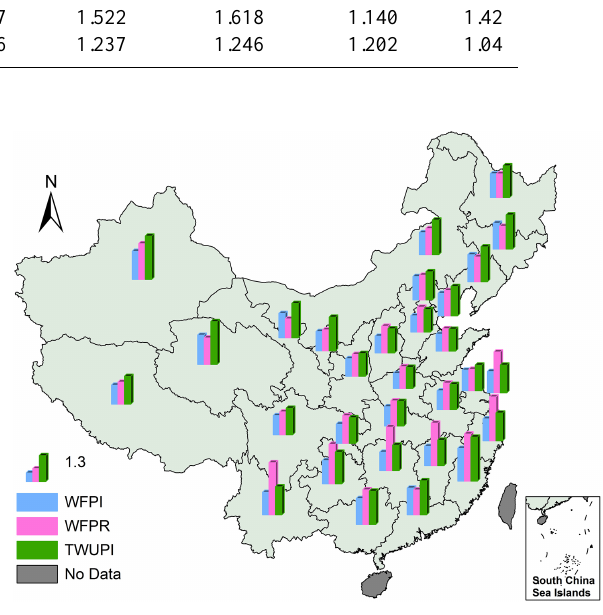
Figure 6. Water footprint and total water use per kilogram of wheat product in irrigated and rainfed lands in